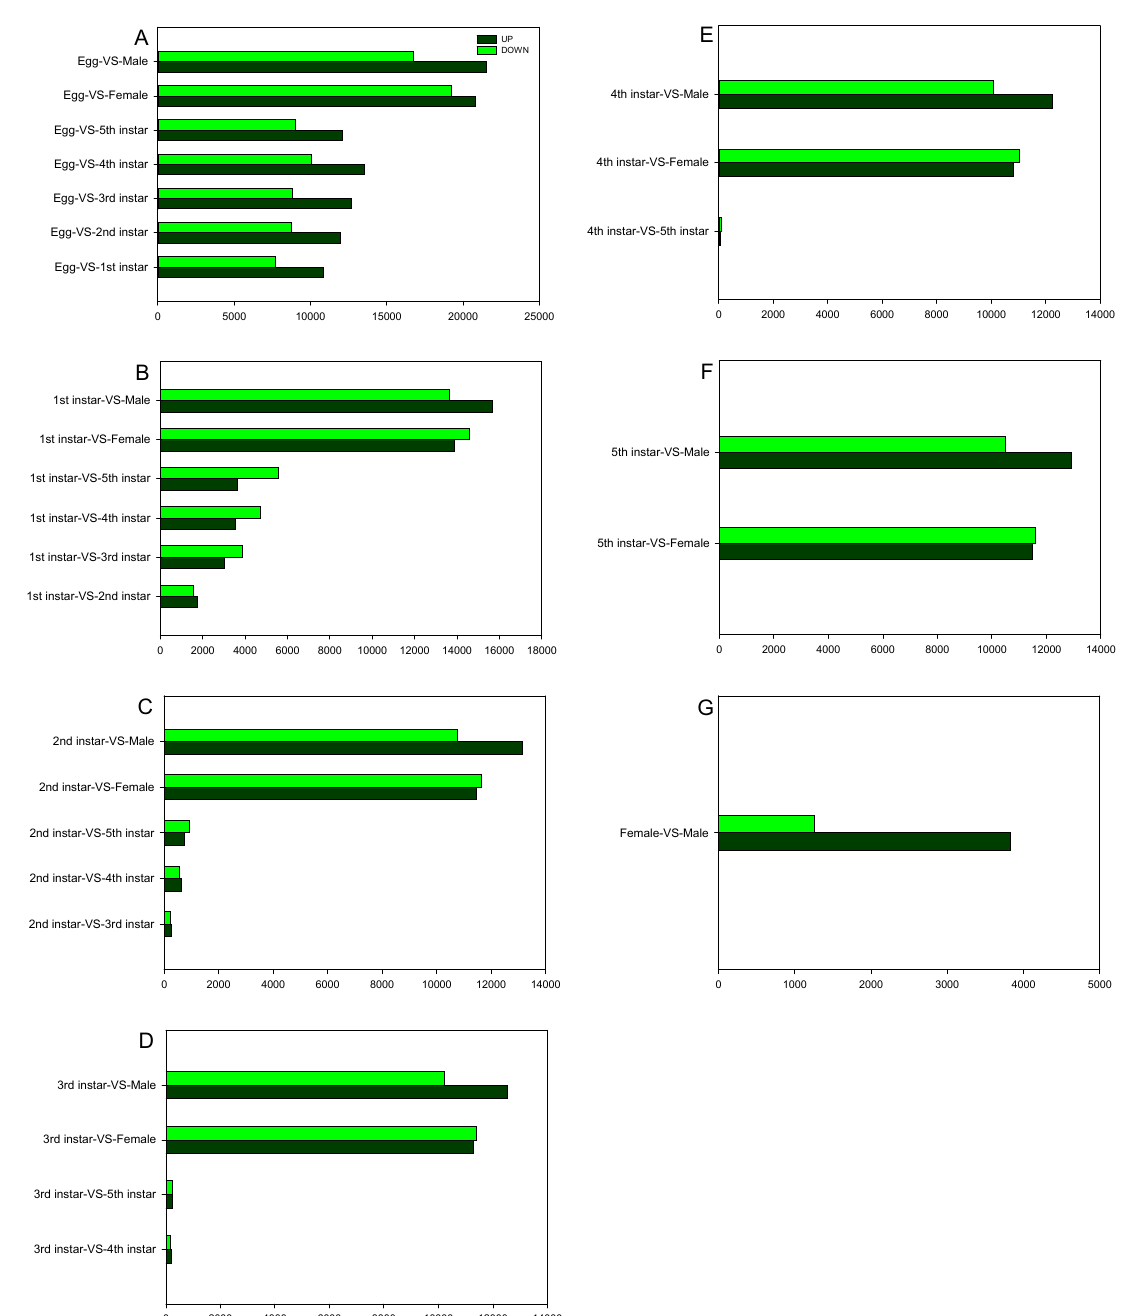
Figure 7. Comparison of differentially expressed gene (DEG) numbers in each. Upregulated (UP) and downregulated (DOWN) unigenes were quantified. The results of 28 comparisons are shown. ( A ) the comparison of DEGs between egg and other stages; ( B ) the comparison of DEGs between 1st instar and other stages; ( C ) the comparison of DEGs between 2nd instar and other stages; ( D ) the comparison of DEGs between 3rd instar and other stages; ( E ) the comparison of DEGs between 4th instar and other stages; ( F ) the comparison of DEGs between 5th instar and other stages; ( G ) the comparison of DEGs between female and